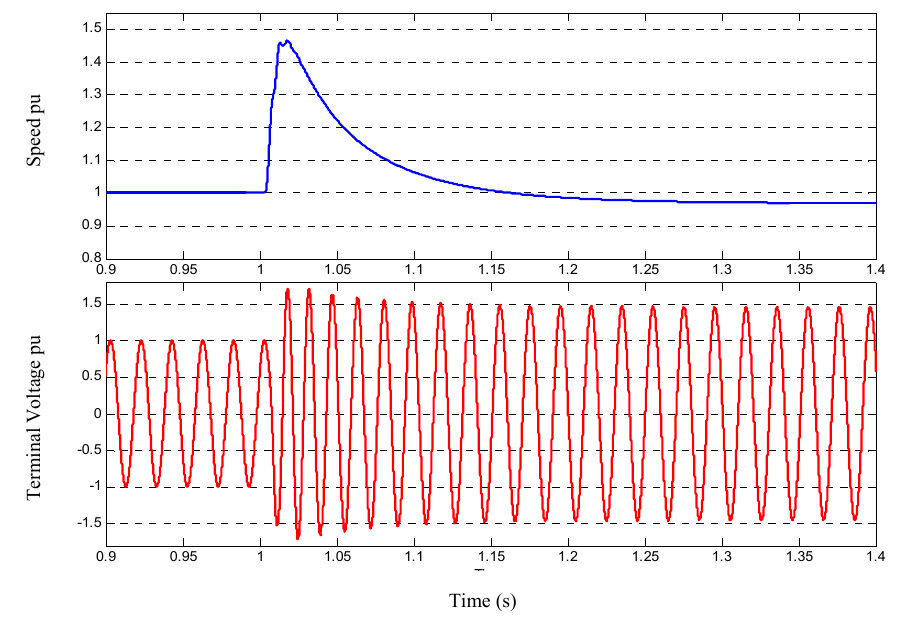
Figure 10. The machine islanded with 40% active and 40% reactive